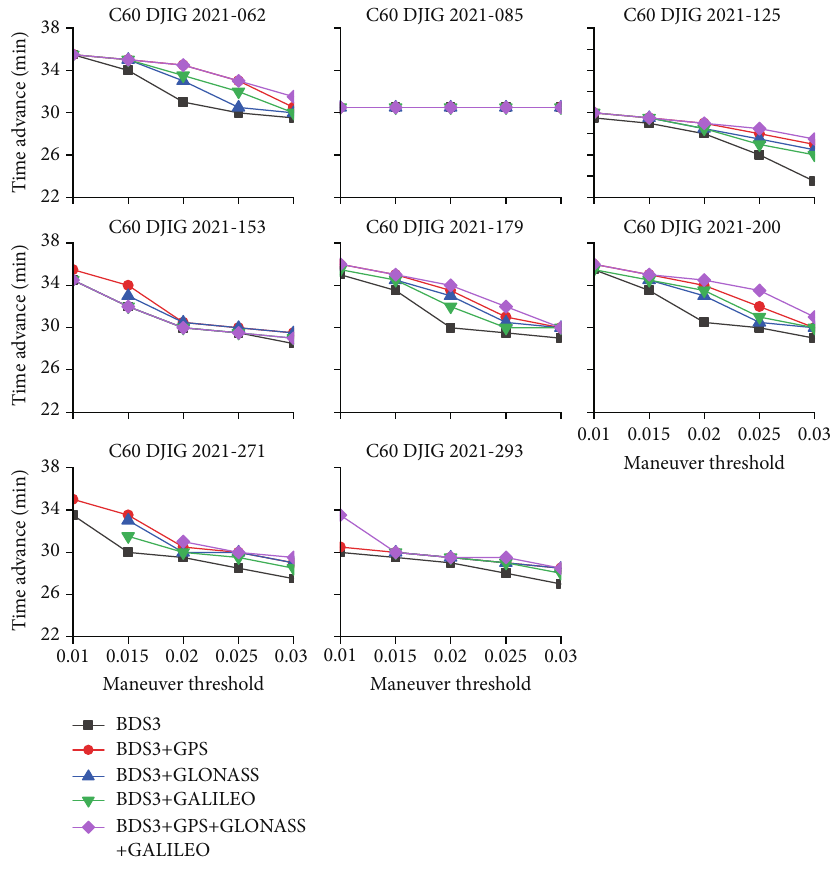
Figure 7: Comparison of detection results of C60 under di ff erent maneuvering thresholds.